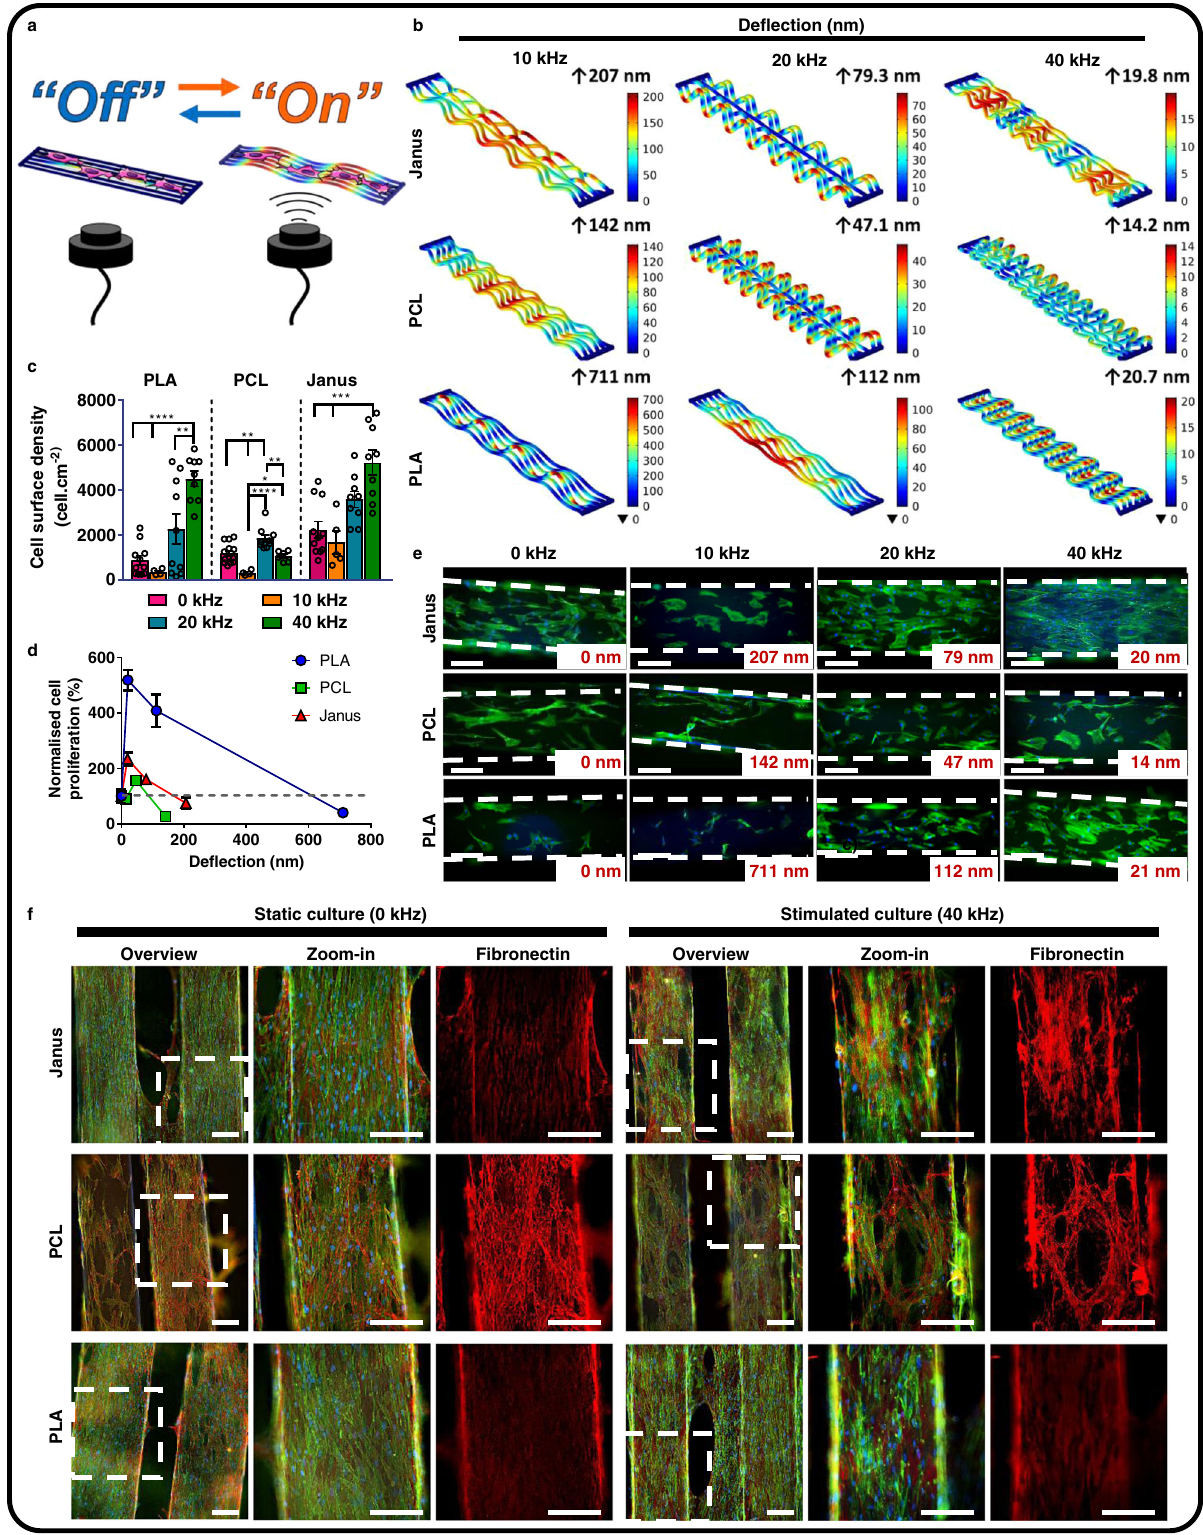
Overview Zoom-in FibronectinOverview